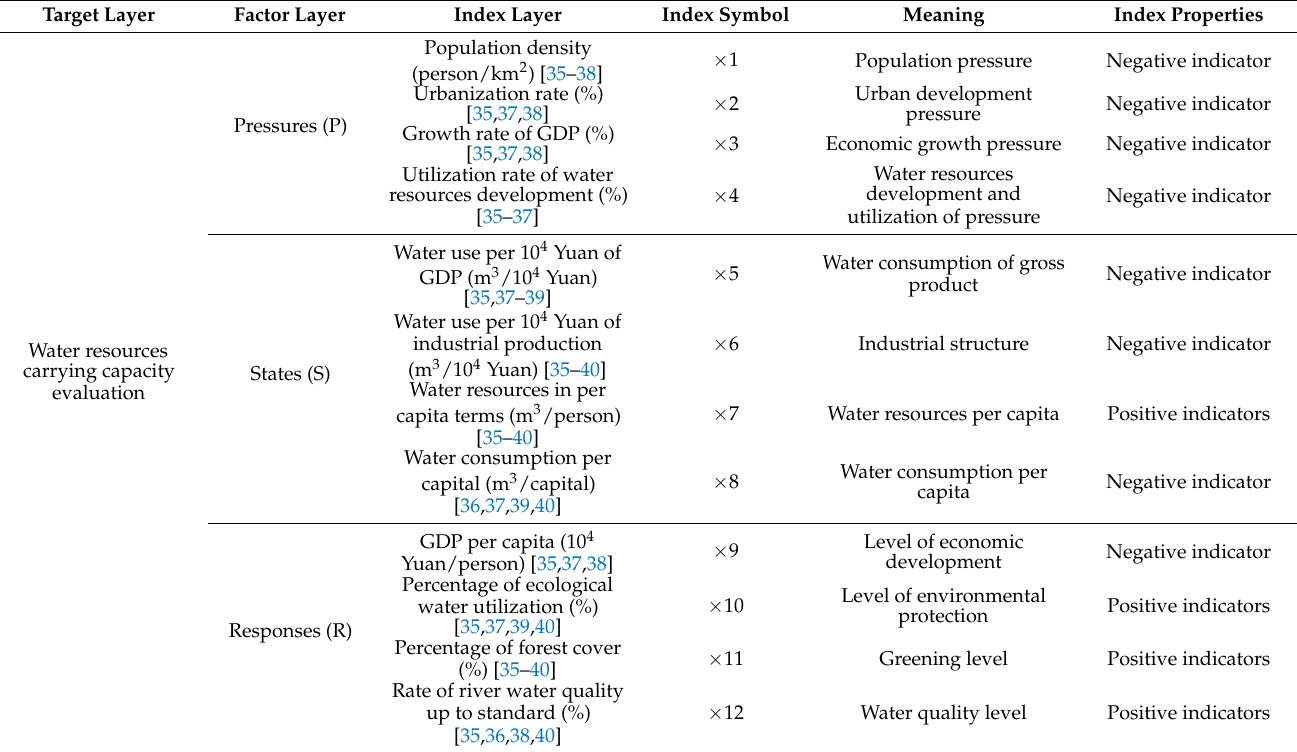
Table 1. Evaluation index system of water resources carrying capacity in the study